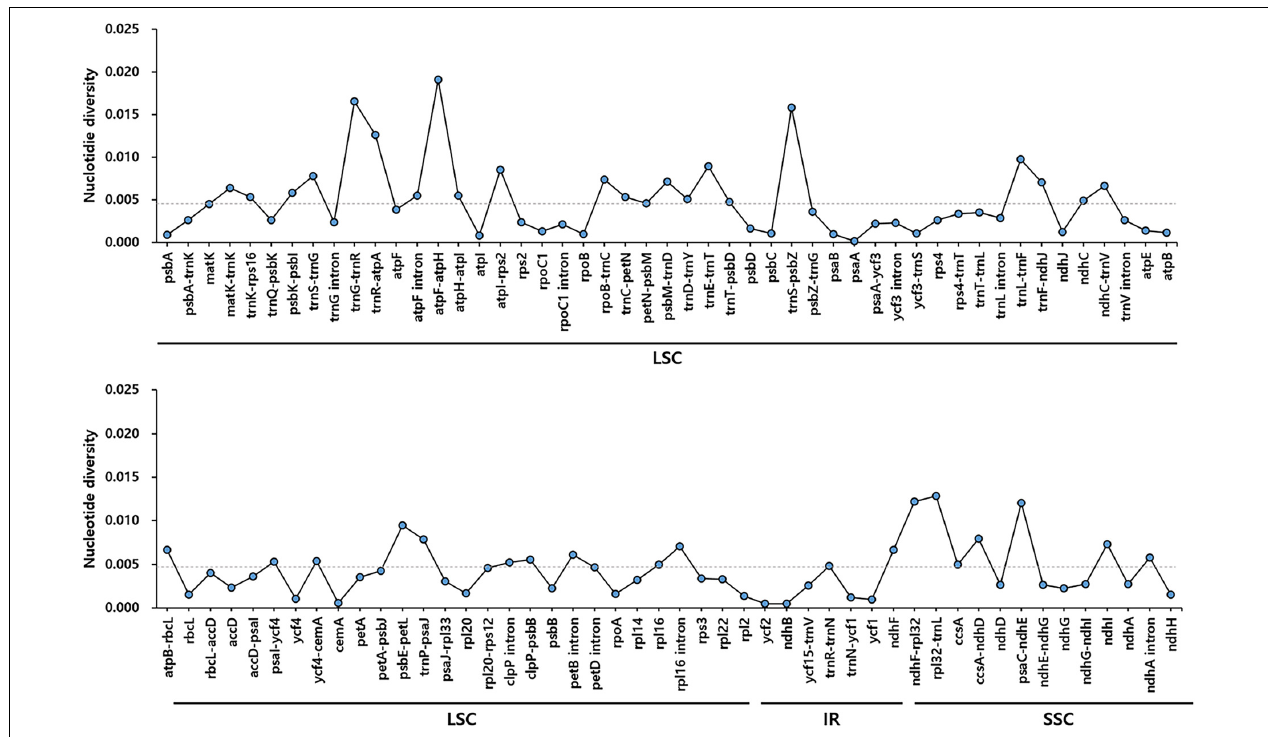
FIGURE 5 | Comparison of nucleotide diversity (Pi) values among the five Trichosanthes species. The dotted line indicates the average Pi value by gene and intergenic region in five Trichosanthes plastid genomes. Regions with Pi = 0 were excluded.